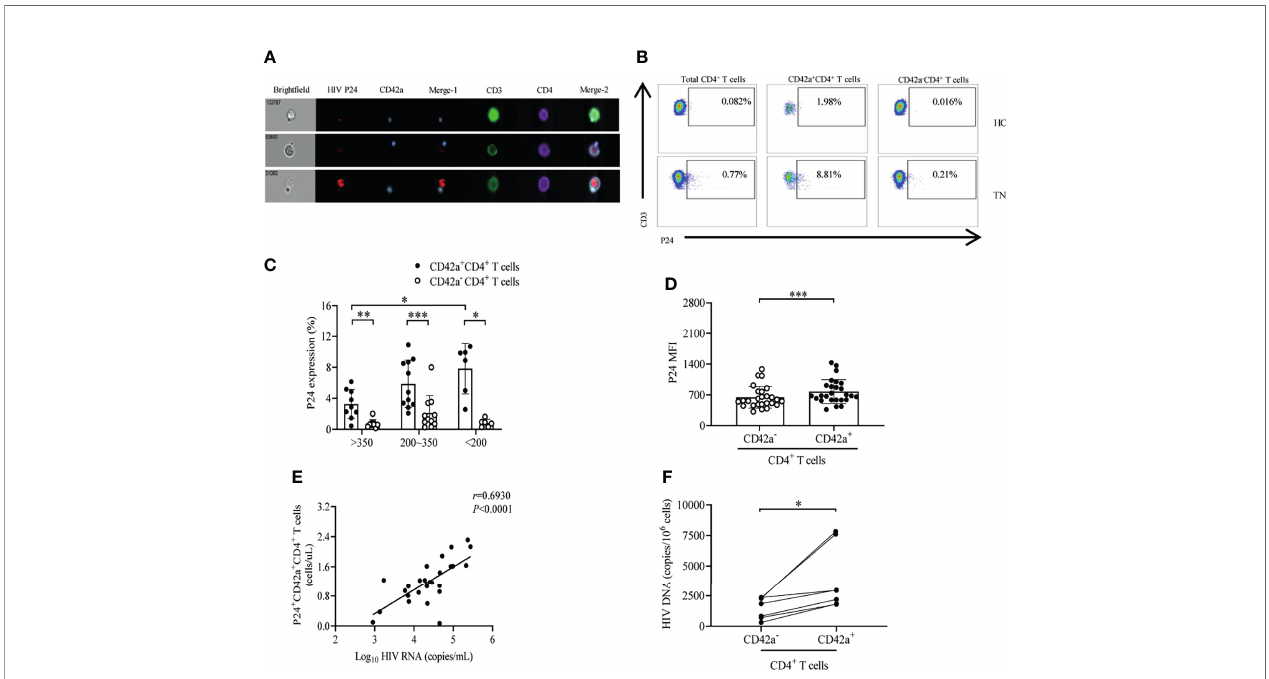
FIGURE 3 | Elevated levels of HIV-1 p24 and DNA in platelet-CD4 + T cell aggregates. (A) Representative images of p24 expression in platelet-CD4 + T cell aggregates via imaging fl ow cytometry from a treatment-naïve patient. Top row: p24 visualized only in the platelets of platelet-CD4 + T cell aggregates. Middle row: p24 visualized only in the CD4 + T cells. Bottom row: p24 visualized in both platelets and CD4 + T cells. (B) Representative gating strategy for p24 expression in platelet-CD4 + T cell aggregates and their counterparts from TNs and HCs. (C) P24 expression in platelet-CD4 + T cell aggregates and their counterparts in different groups of treatment-naïve HIV-1-infected subjects. CD4 + T cell counts>350 cells/ m L (n=9), 200 ≤ CD4 + T cell counts ≤ 350 cells/ m L (n=11), CD4 + T cell counts<200 cells/ m L (n=6). (D) Median fl uorescence intensity (MFI) values of p24 were compared between platelet-CD4 + T cell aggregates and their counterparts in TNs (n=26). (E) Correlation between HIV-1 viral load and platelet-CD4 + T cell aggregates expressing p24 in TNs (n=26). (F) Platelet-CD4 + T cell aggregates and their counterparts were isolated from PBMCs of IRs (n=7); HIV-1 DNA was detected in these two cell fractions. * P < 0.05, ** P ≤ 0.01, *** P ≤